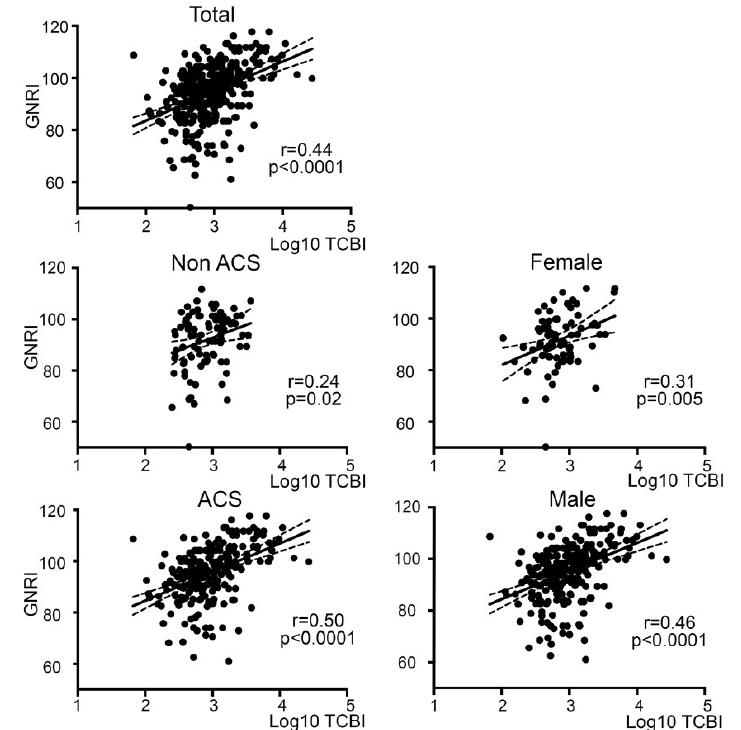
Figure 1. Correlation between TCBI and GNRI in total and subpopulations. Non-parametric Spearman’s correlation coe ffi cients indicated significant, positive and linear correlations between TCBI and GNRI in all populations. r: Correlation coe ffi